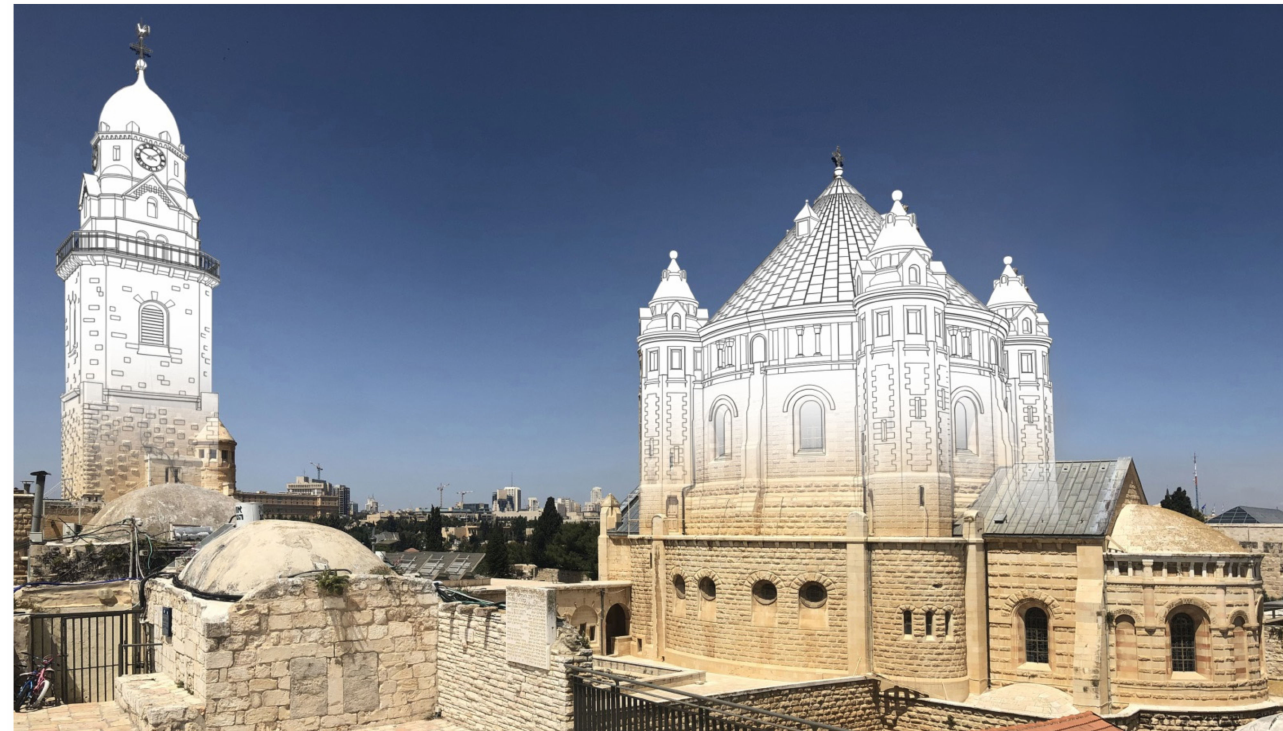
Figure 10. A geometric model of the Basilica of the Dormition of the Blessed Virgin Mary on Mount Zion in